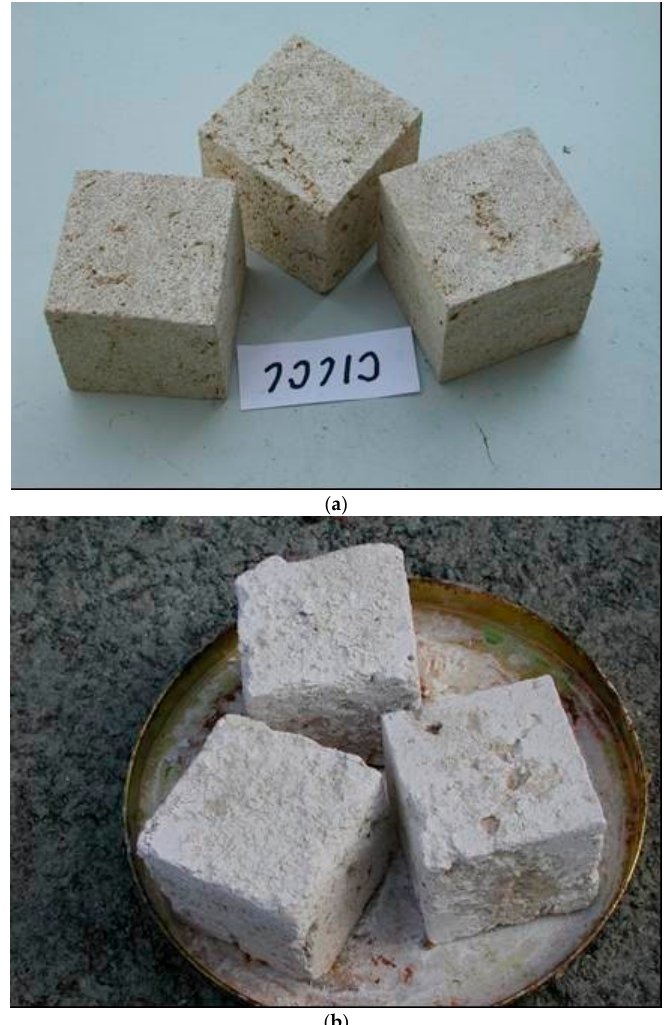
Figure 13. Kurkar sandstone before and after accelerated weathering test in a sodium sulfate solution. ( a ) Unweathered stone samples. ( b ) Stone samples after accelerated weathering test